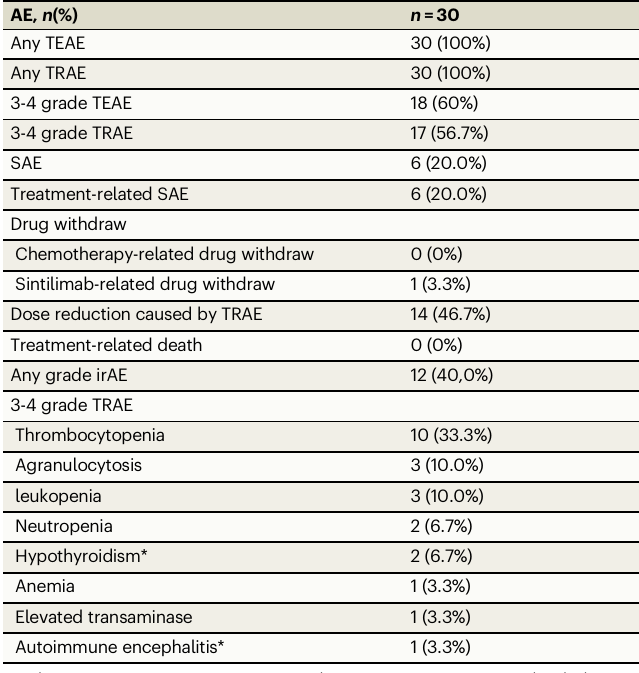
Table 2 | Adverse events in all treated